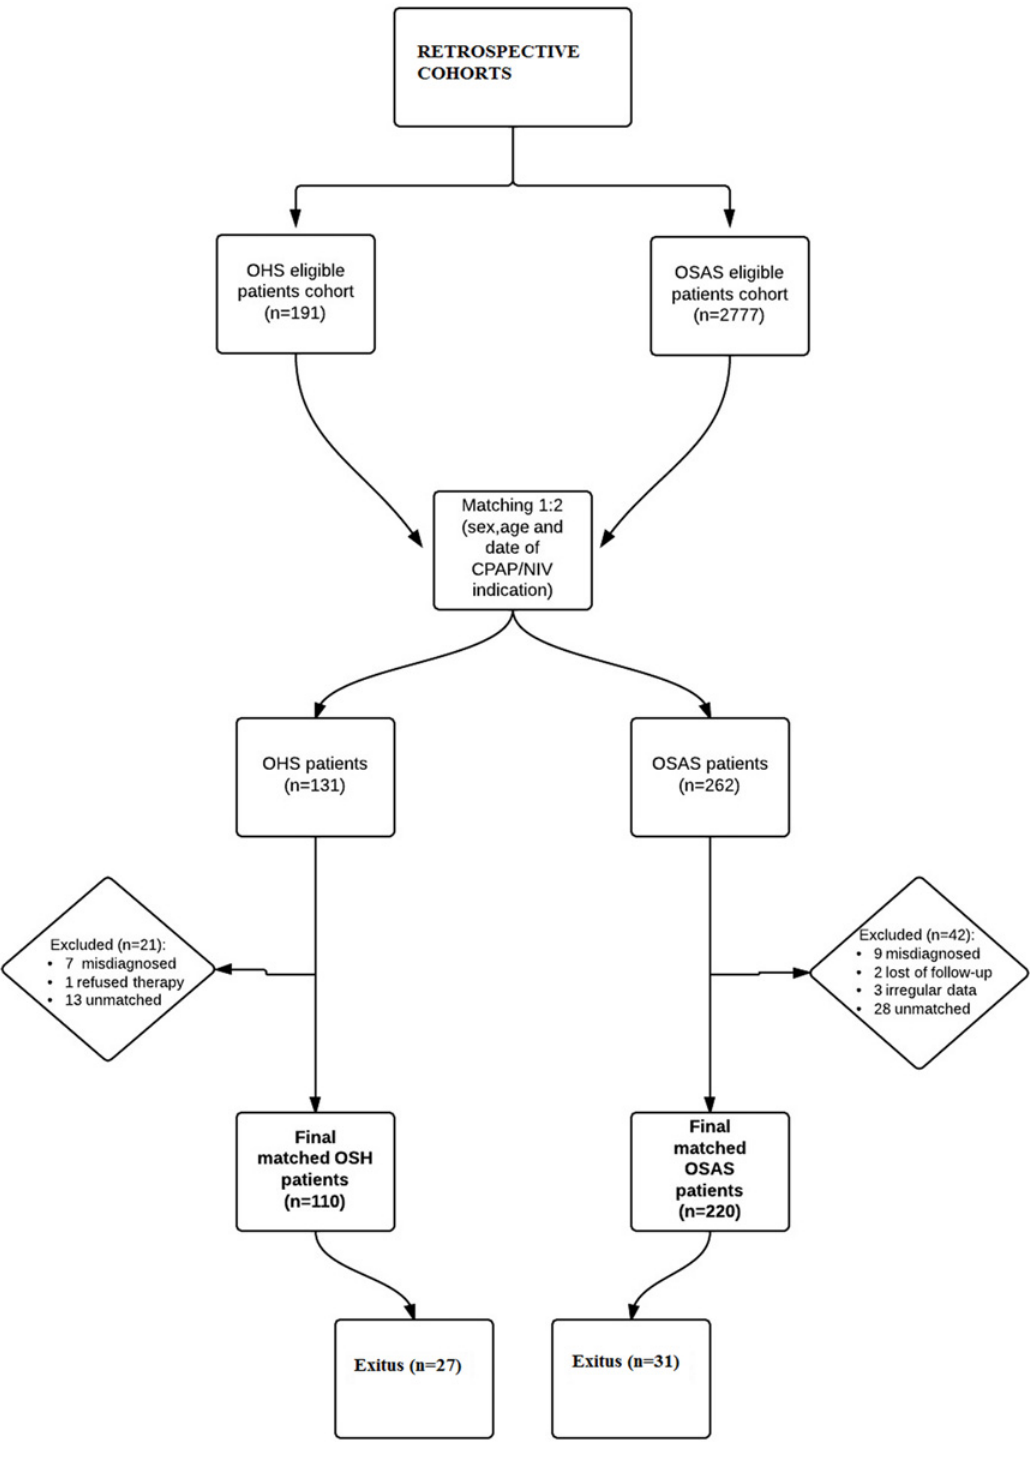
Fig 1. Flow-chart diagram of the study.